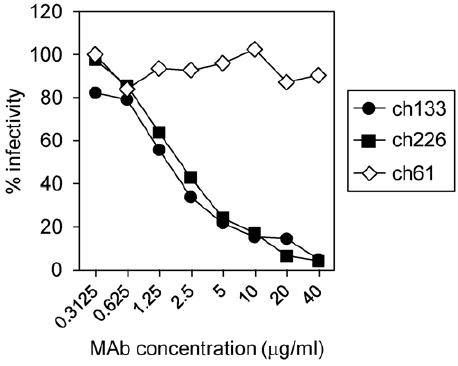
Figure 2. Chimeric MAbs neutralize ZEBOV. The indicated concentrations of MAbs were incubated with 200 focus-forming units of ZEBOV for 1 hour at 37 u C and subsequently inoculated onto monolayers of Vero E6 cells in a 48-well plate. After incubation for 4 days at 37 u C, cells were fixed and removed from BSL4 using standard operating procedures. Foci were stained with an anti-VP40 rabbit serum and a FITC-conjugated anti-rabbit IgG antibody, counted and titers were